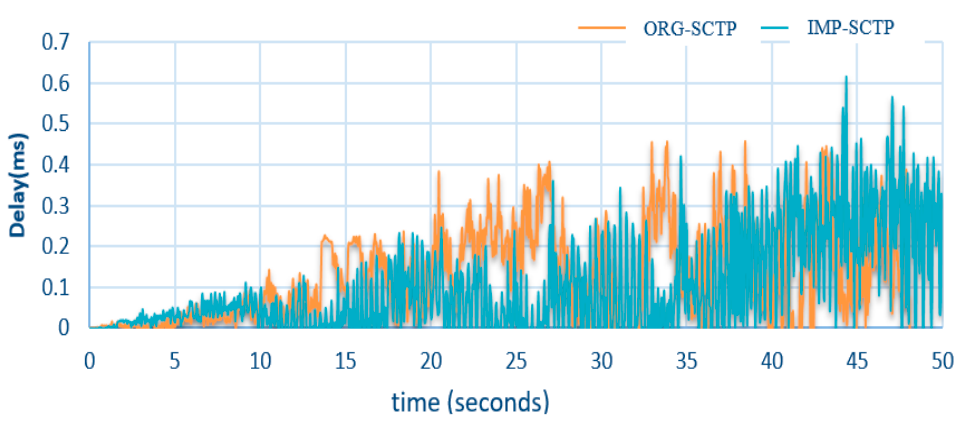
Figure 9. Delay of ORG-SCTP and improved SCTP (IMP-SCTP).